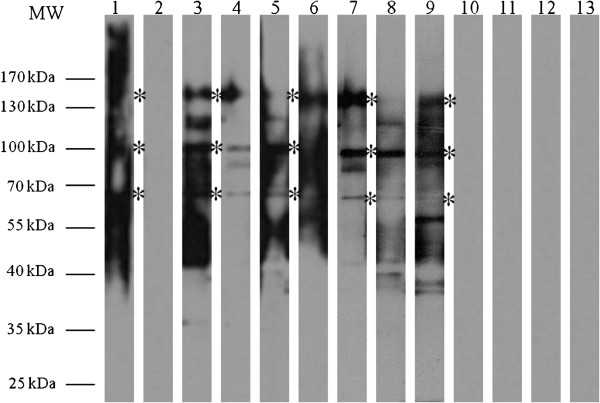
Western blot profile of CSA probed with representative individual human serum. Lane MW: Molecular weight standard (PageRulerTM Prestained Protein Ladder); Lane 1: Pooled human ALA serum; Lane 2: Pooled human IHA seronegative serum; Lanes 3 to 9: Individual human ALA serum; Lanes 10–12: Individual human IHA seronegative serum; Lane 13: TBS control. (*) indicates the estimated molecular weight of proteins (~170 kDa, ~100 kDa and ~70 kDa).